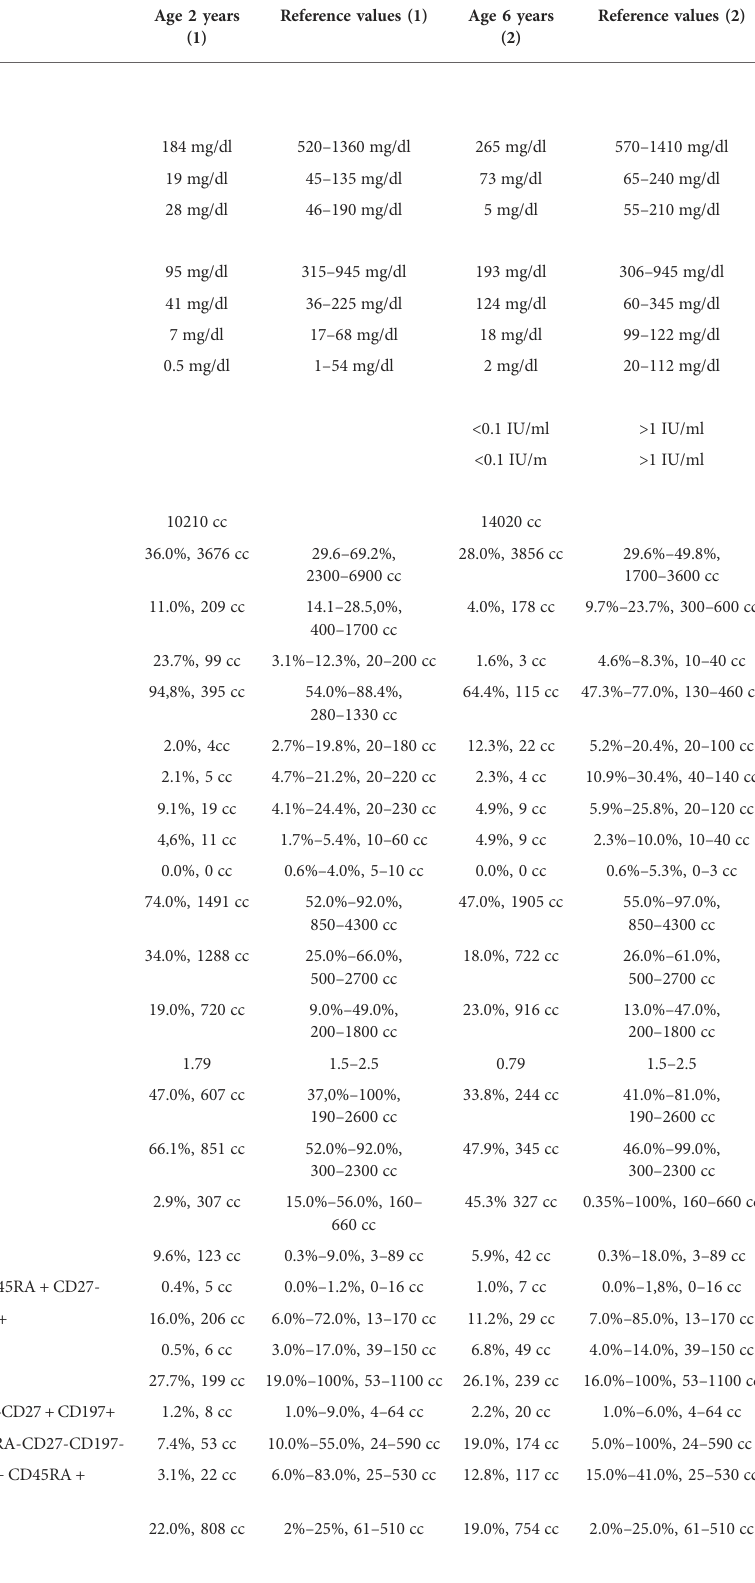
TABLE 1 The immunological workup with antibody-mediated response and peripheral blood fl ow cytometric immunophenotyping in the CFCS